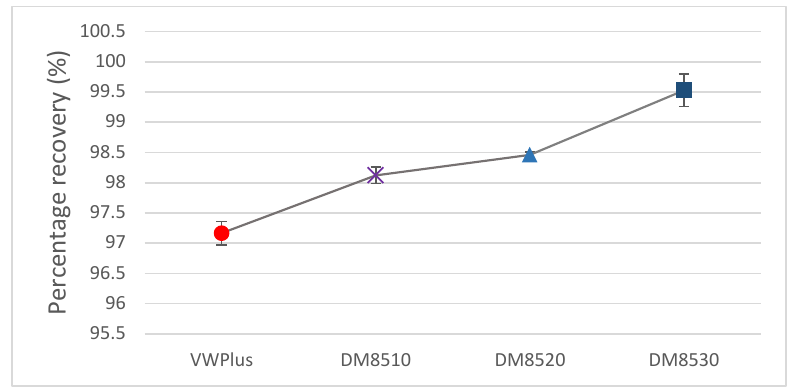
Figure 14. Percent recovery comparison of the four materials.